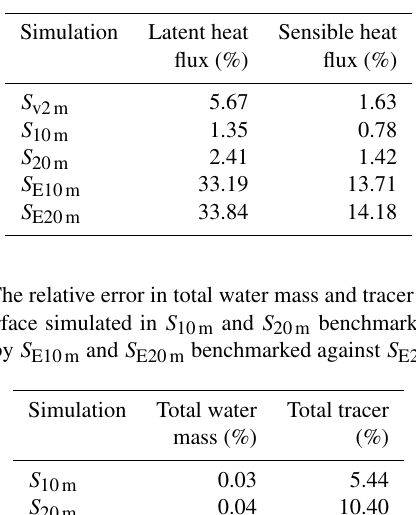
Table 4. The relative error in surface energy fluxes simulated by S 10m and S 20m benchmarked against S 2m and by S E10m and S E20m benchmarked against S E2m .